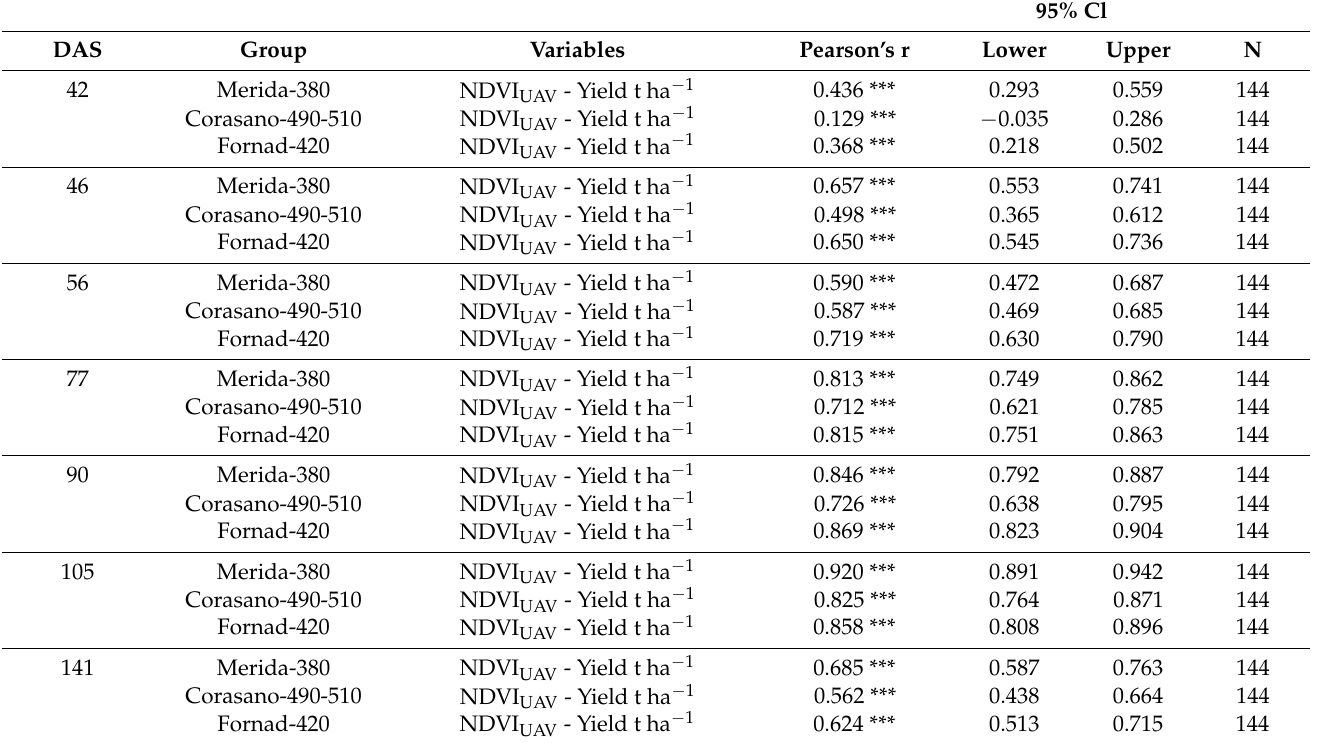
***. Correlation is significant at the 0.001 level; confidence level (Cl) 95%. In the initial development, the Corasano FAO-490-510 hybrid shows a weak correla- tion with yield (r = 0.129), which can be explained by its mid − late maturity (Figure 11). The hybrids show the strongest correlation at different times during the growing season: Merida FAO-380 at 105 days after sowing (r = 0.920), Fornad FAO-420 at 90 days after sowing (r = 0.869), and mid − late maturing Corasano FAO-490-510 at 105 days after sowing (r = 0.825). Examining the effect of nutrient levels on NDVI UAV values (Figure 12) at different measurement times, the difference was statistically confirmed ( p < 0.001). For all DAS, the 160 kg ha − 1 N dose resulted in higher NDVI values. A nutrient level of 80 kg ha − 1 N resulted in 6.5% lower values in the DAS average, while the control was 15.5% lower. The Pearson correlation values (r) show a large variation with N ha − 1 fertilization in In autumn 2020, both the 80 kg N ha − 1 and 160 kg N ha − 1 treatments received the same amount of nutrients, therefore the 160 kg N ha − 1 nutrient level shows a lower (weak) correlation with yield at the initial developmental stages. After top-dressing in June, on day 77 after sowing, there is already a strong correlation between NDVI UAV measured at 160 kg N ha − 1 nutrient level and yield (r = 0.801). The control plots show weak to moderate correlations throughout the growing season (r = − 0.058–0.563). The 80 kg N ha − 1 nutrient level shows a strong coupling at days 77 and 90 after sowing (r = 0.704; 0.721), as shown in Figure